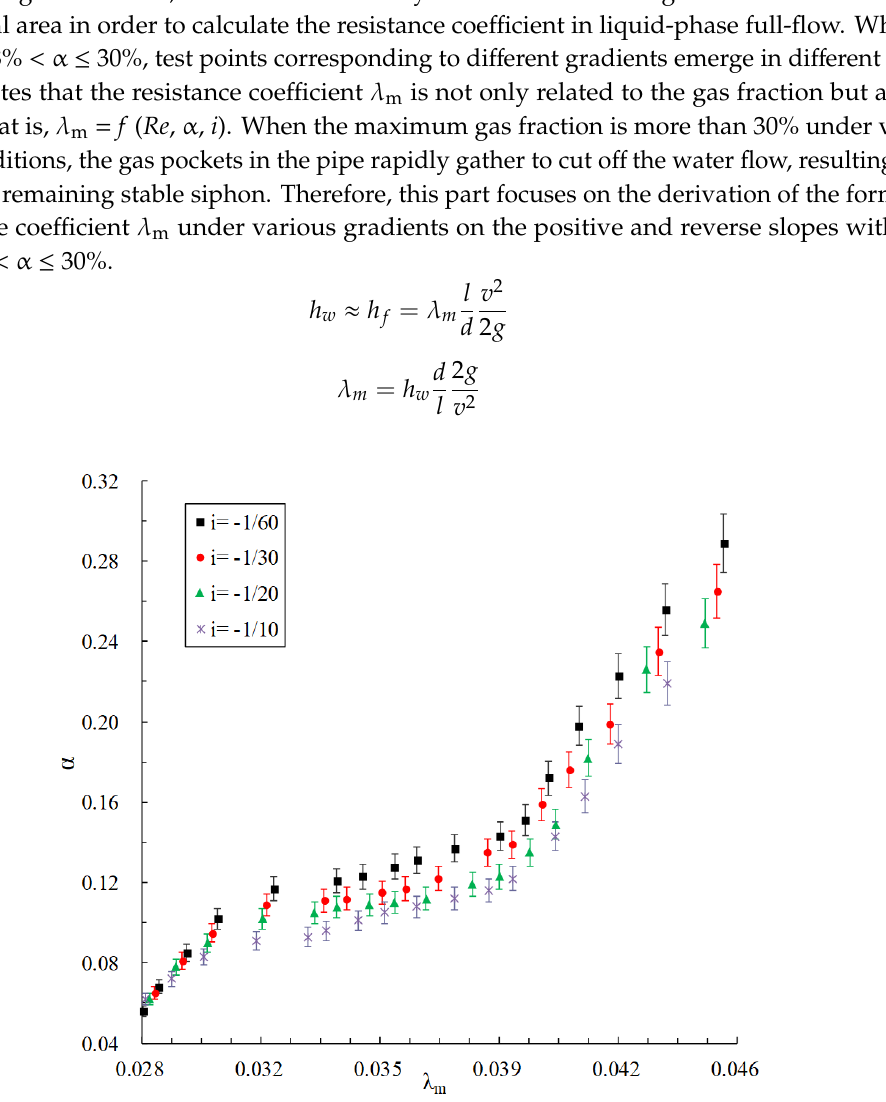
Figure 9. Relationship between the resistance coefficient λ m and gas fraction under various gradients.